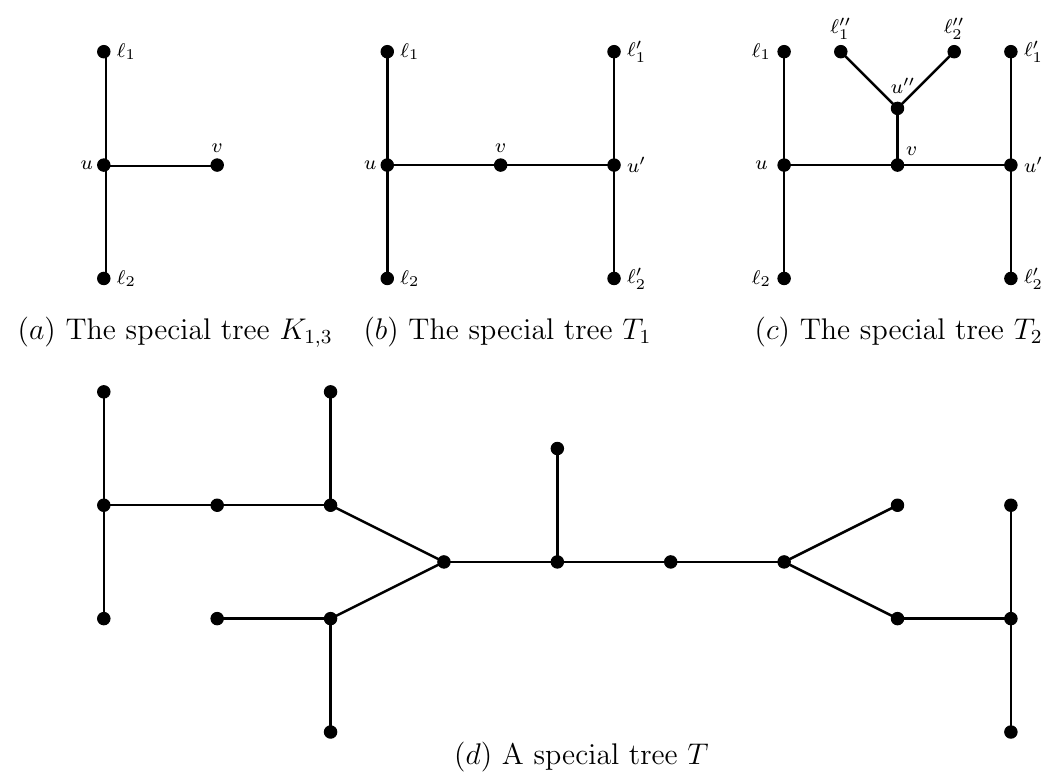
( d ) A special tree T Figure 1: Examples of special